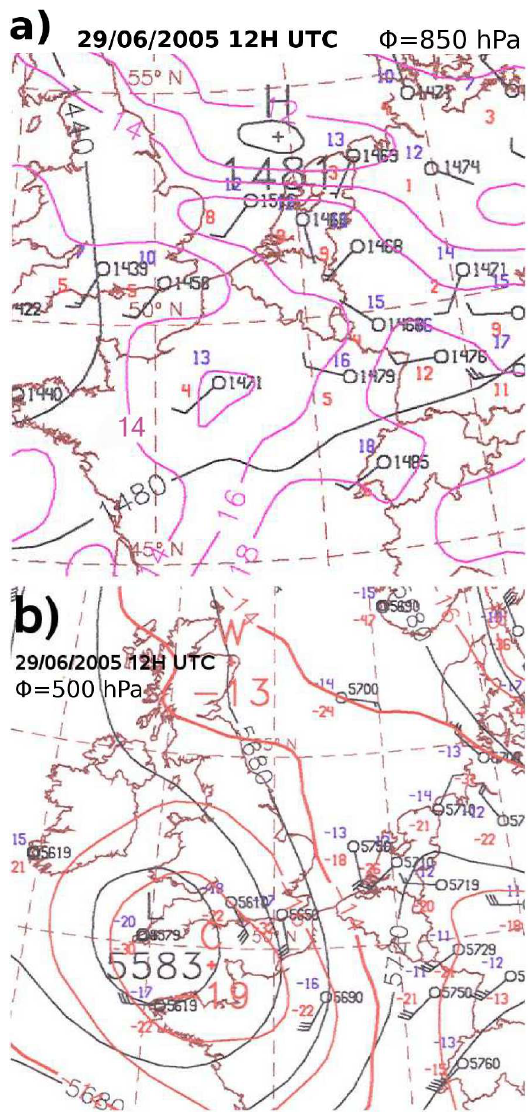
Figure2. Isobaric analysis a) at 850 hPa, b) at500 hPa over Western Europe derived from ECMWFbackground and radiosondes observations (2005/06/29). The black contours are the geopotential heights. The magenta contours represent the wet-bulb pseudo-equivalent potential temperature. The observed radiosonde data are pointed on the chart (temperatures in blue, dew point temperatures in red, wind flags and geopotential heights in black).